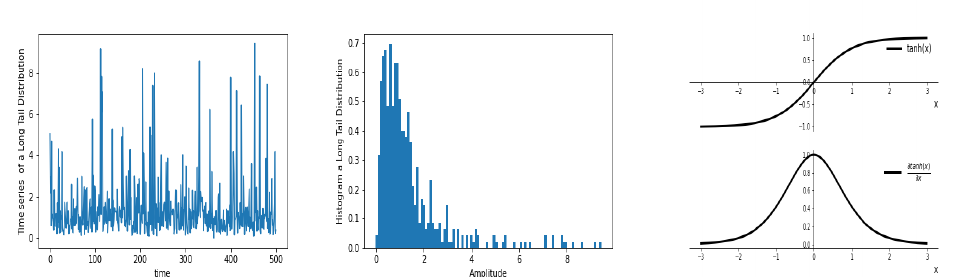
Figure 15. ( Left ) Example of a time series with a Long Tail distribution, ( Center ) Histogram of the time series, ( Right ) Comparison of the Tanh nonlinearity with its’